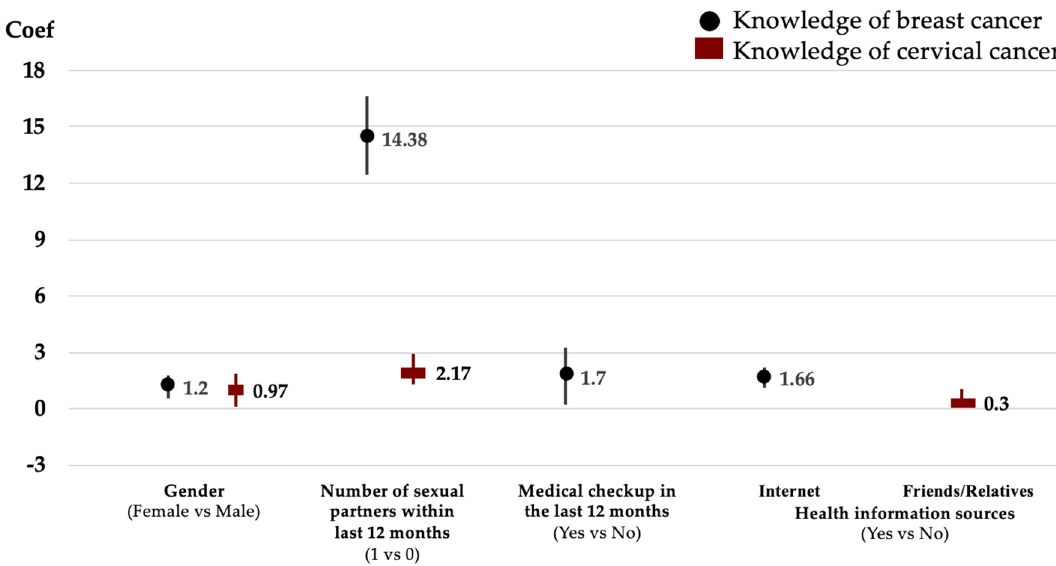
Figure A1. Significant factors associated with knowledge of breast cancer and cervical Figure A1 . Significant factors associated with knowledge of breast cancer and cervical cancer